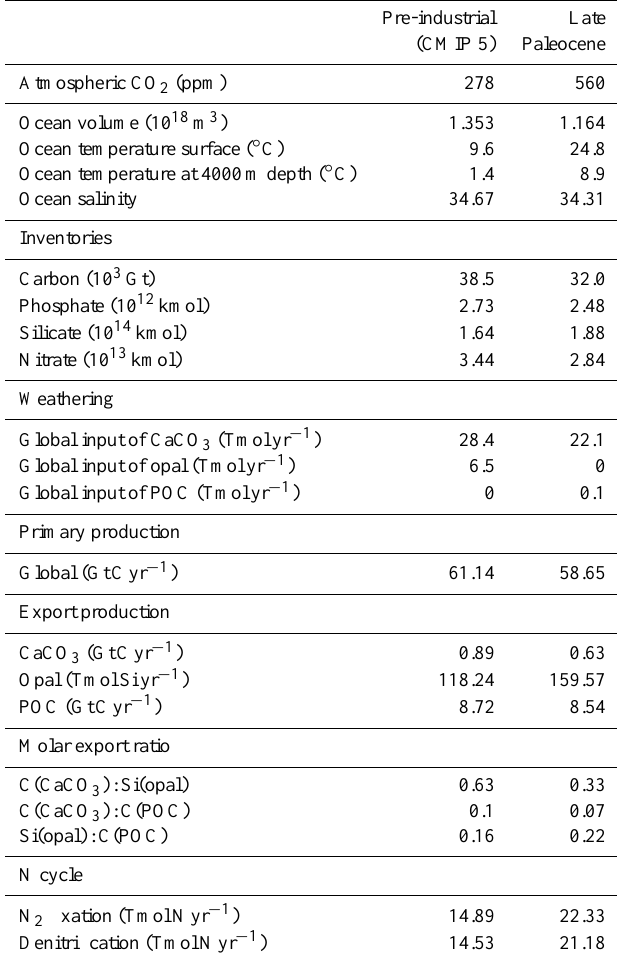
Fig. 3. Sea surface temperature (°C) (left) and salinity (right); for the surface (a,b), Pacific (c,d), and Atlantic (e,f) averaged meridional cross cut. Note the non-linear vertical axes, used to zoom in the upper ocean layers.